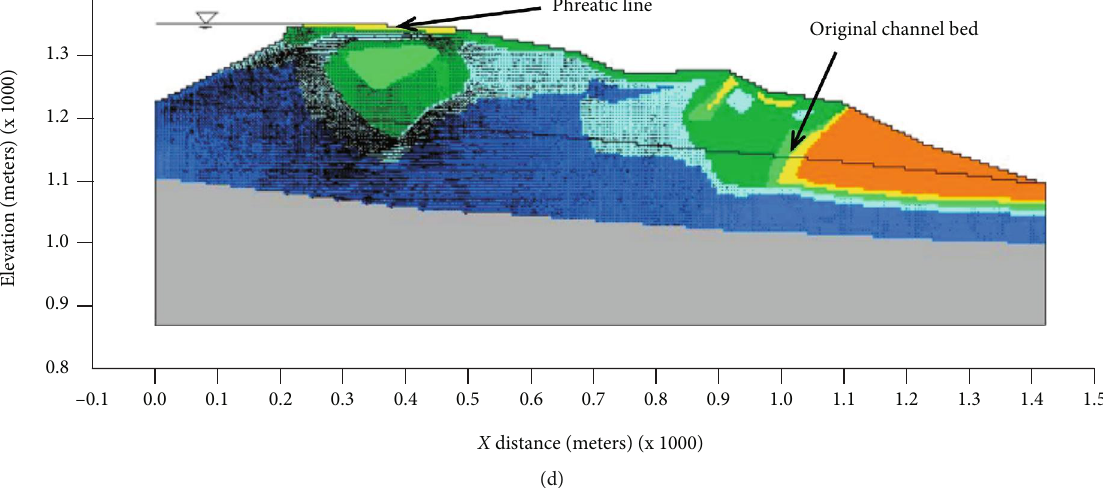
Figure 22: SEEP/W simulation results for Karli spillway (lake level at 1352m AMSL): (a – c) fl ow paths, total head contours, and velocity vectors, respectively, for the head at the downstream toe end equal to the original channel bed, and (d) velocity vectors for zero fl ux at the downstream toe